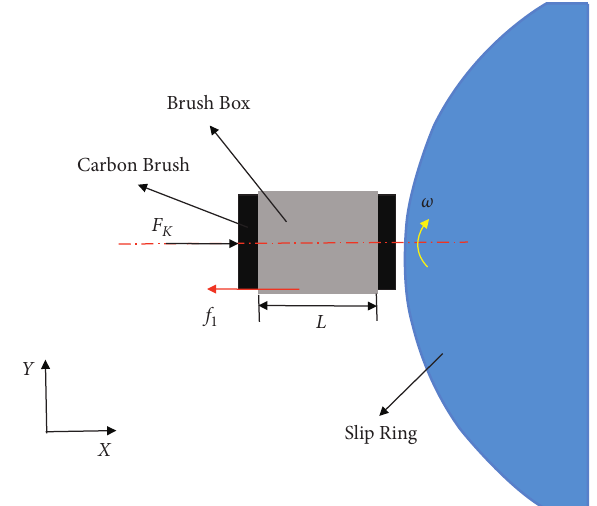
Figure 5: Force diagram of the carbon brush under loss of contact.